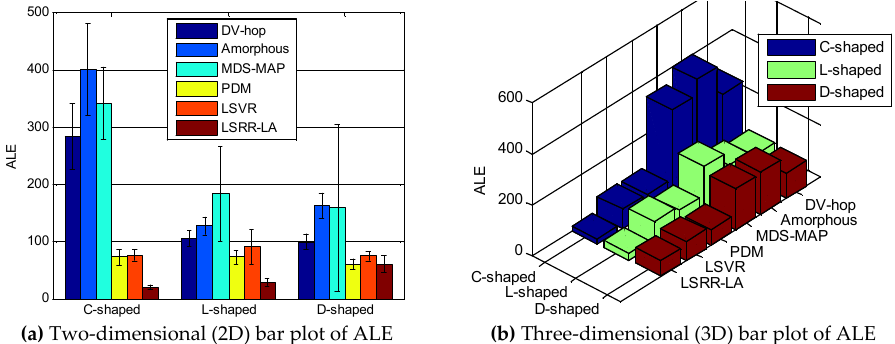
Figure 3. Comparison of ALE when R = 100m and M = 20%.